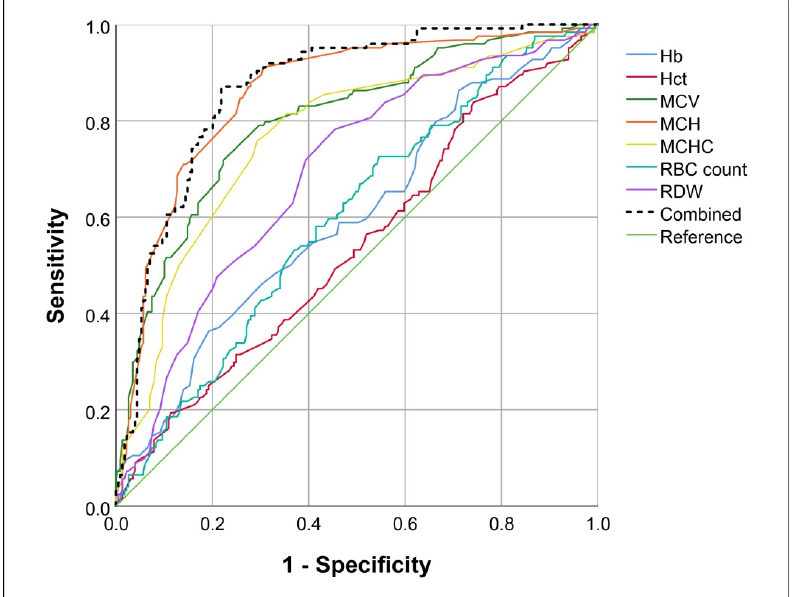
Figure 1. ROC curves show the diagnostic performance of red blood cell indices in predicting the α + -thalassemia trait. Hb, hemoglobin; Hct, hematocrit; MCH, mean corpuscular hemoglobin; MCHC, mean corpuscular hemoglobin concentration; MCV, mean corpuscular volume; RBC, red blood cell; RDW, red blood cell distribution width. Table 3. Performance of red blood cell parameters in predicting the α + -thalassemia trait. Red Blood Cell Parameters